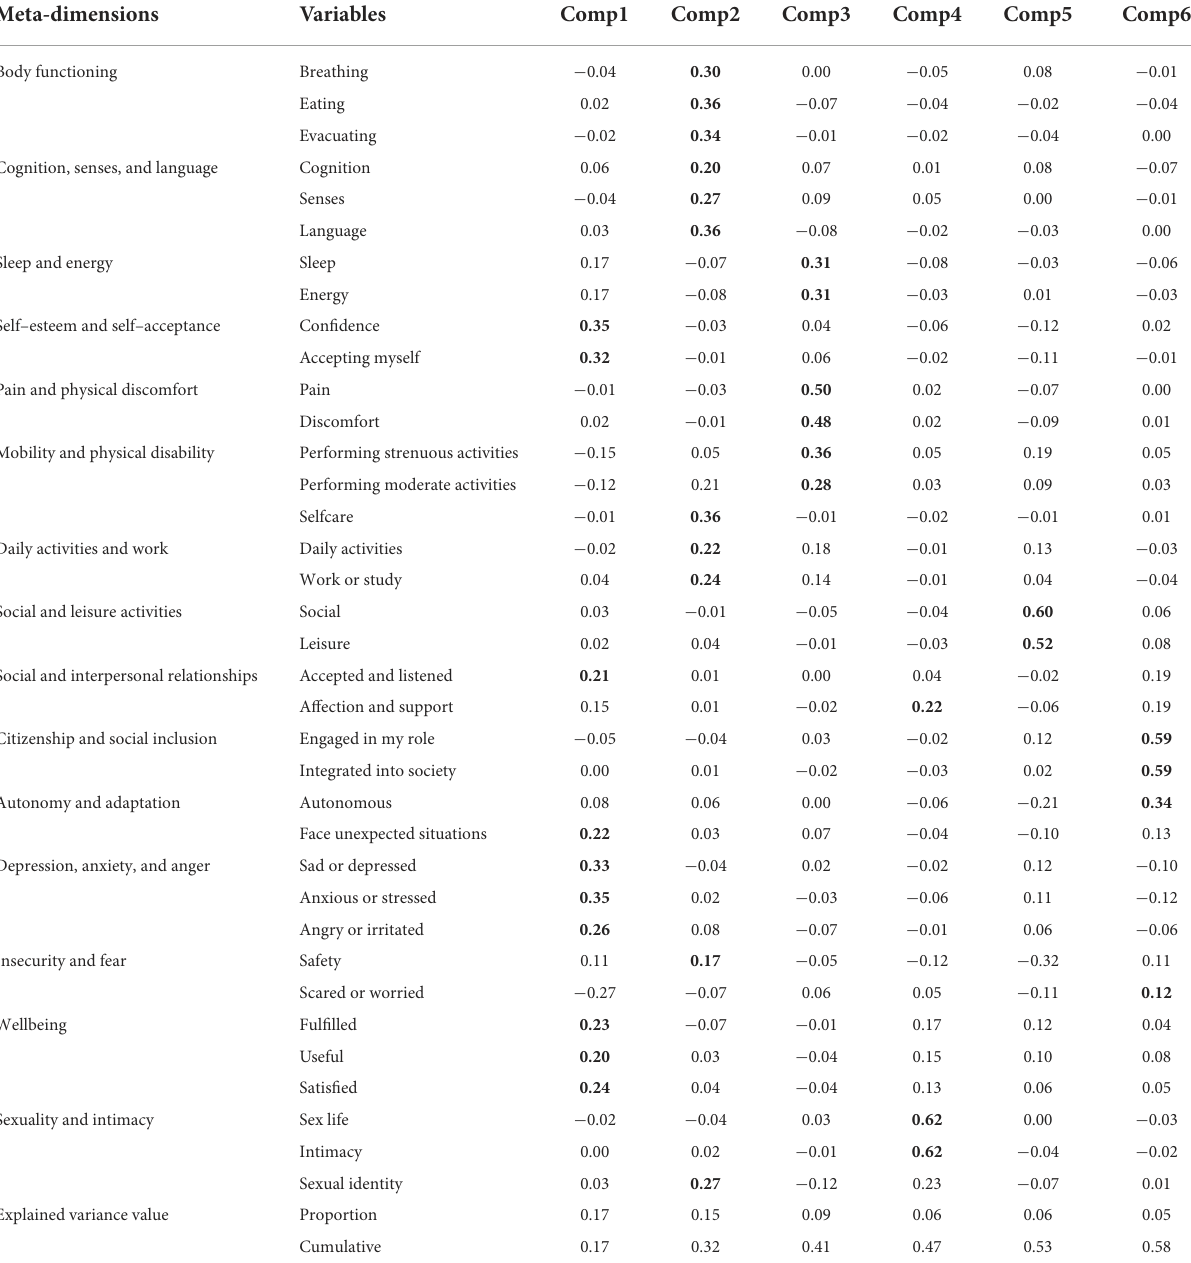
TABLE 7 Items ponderation in PCA with varimax